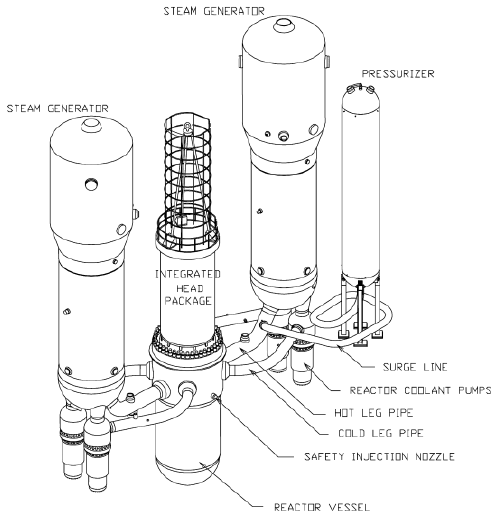
Figure 1. Flowsheet of AP1000 reactor coolant system.